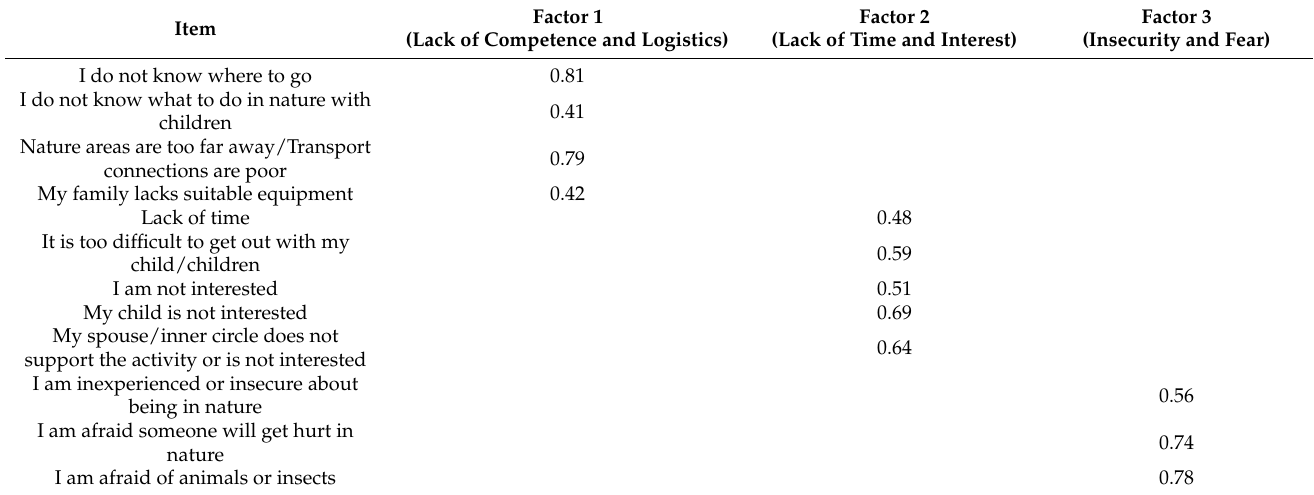
Table 2. Items and factor loadings for parents’ perceived barriers.